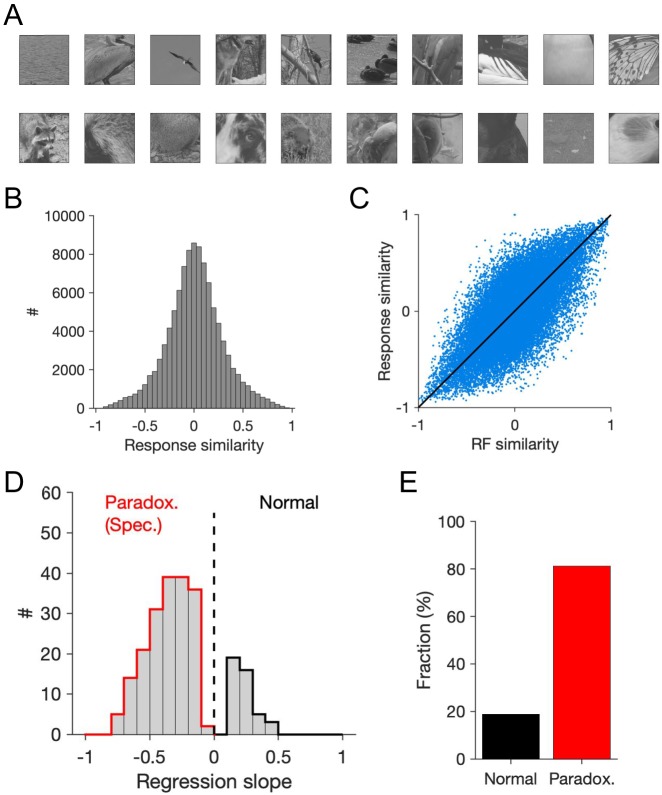
Feature-specific paradoxical effects obtained by perturbing inhibitory neurons based on their response similarity to natural images.(A) Example natural images used to probe the response similarity of inhibitory neurons. (B) Distribution of response similarity of responsive inhibitory neurons, when the network is stimulated with natural images (see Materials and methods). (C) Response similarity versus RF similarity. (D) Distribution of patterned perturbations based on reference inhibitory neurons leading to a significant negative slope (specific paradoxical effect; red) or not (significant positive slope; black). (E) Fraction of patterned perturbations (based on response similarity to reference inhibitory cells) leading to paradoxical effect or not. Other conventions are the same as Figure 4.